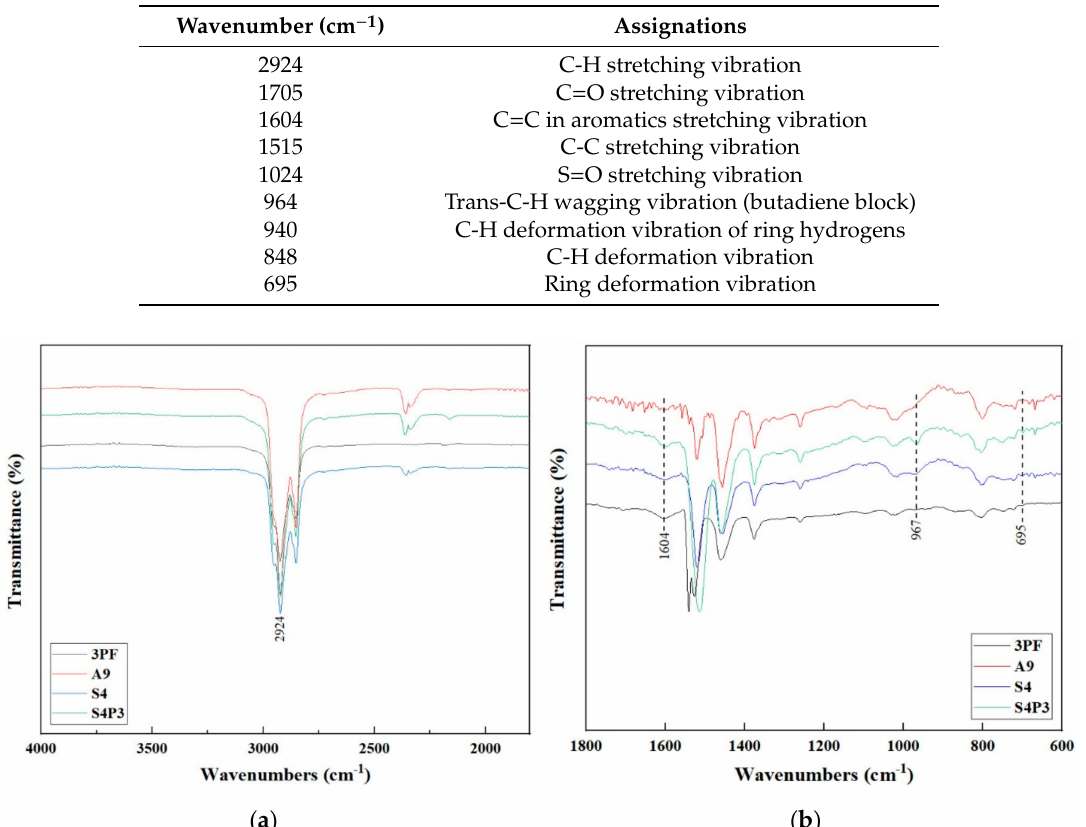
Table 4. Assignment of the main bonds in the Fourier-transform infrared (FTIR) spectrum.